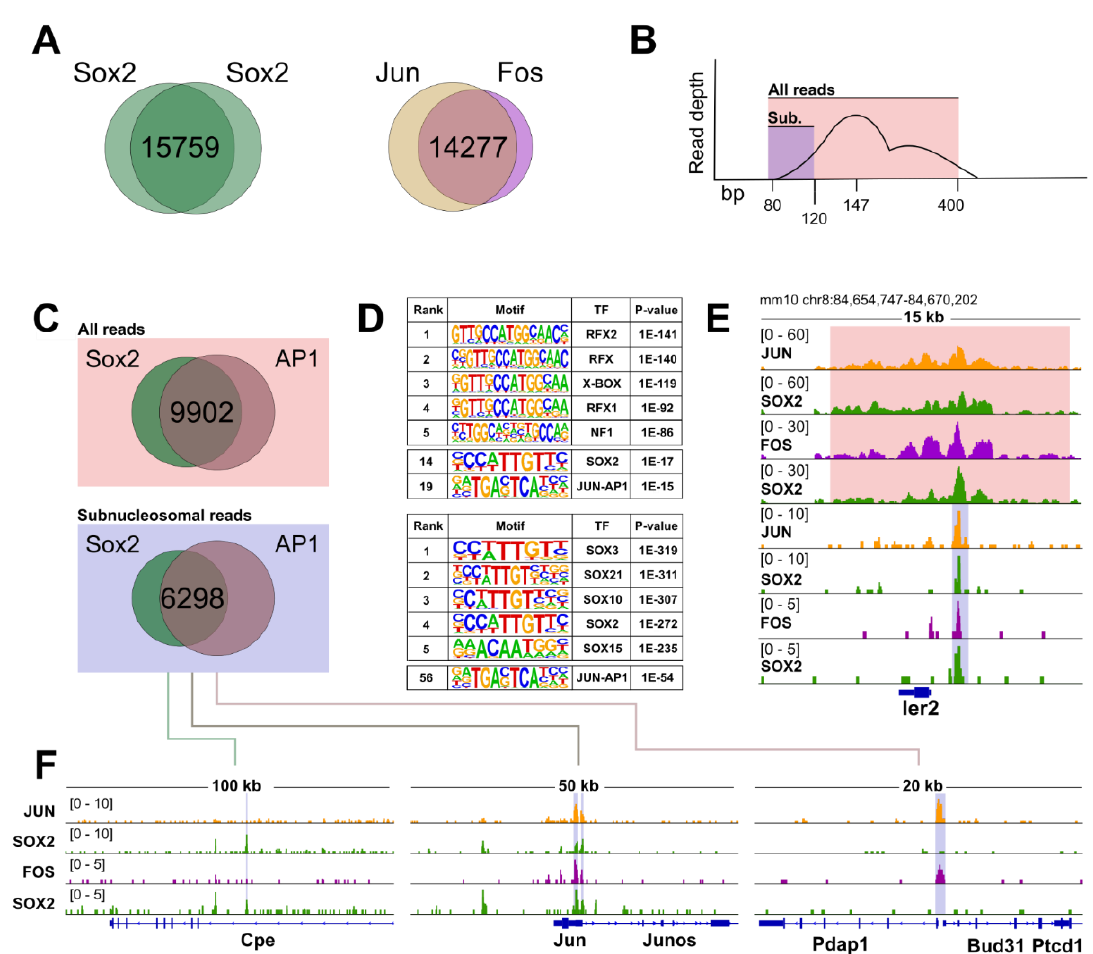
Figure 4. Genome-wide binding of SOX2 and AP1. CUT&RUN of AP-1 and SOX2. ( A ) Peaks were called for the SOX2, FOS, and JUN datasets, revealing overlaps of 15,759, and 14,277 peaks, respectively. ( B ) Schematic representation of our in-silico size selection approach. The semi-transparent boxes indicate the ranges of read size (expressed in base pairs, bp) considered. ( C ) Overlapping peaks called from all reads with a cut-off of 400 base pairs max insert-size yielded 9902 shared peaks. Enriching for subnucleosomal reads/peaks reduced this number to 6298. ( D ) The top five consensus sequences identified from the motif analysis using HOMER, ranked based on increasing p-value (1E represents standard notation for powers of 10; e.g., 1E-141 = 1 × 10 − 141 ). Representative motifs for SOX proteins and AP1 are added below in the same table. Their ranking is indicated with a number on the left. ( E ) IGV tracks of the four samples, showing the different enrichment profiles of the supra- and sub-nucleosomally enriched peaks. ( F ) Representative SOX2 only (left), SOX2/AP1 shared (middle), and AP1 only (right) peaks.